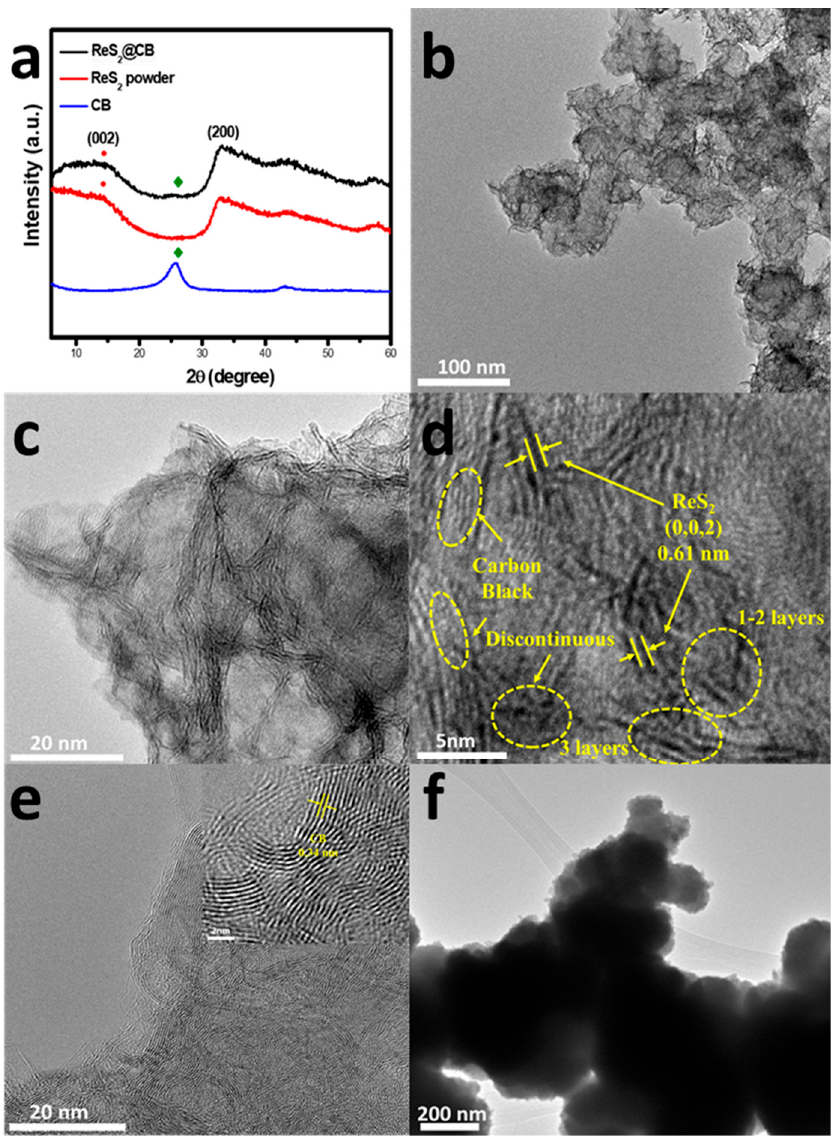
Figure 3. ( a ) XRD pattern of the ReS 2 @CB, ReS 2 powder, and CB; ( b , c ) TEM images of the microstructures of the ReS 2 @CB; ( d , e ) HR-TEM images of the ReS 2 @CB and pure CB; and ( f ) TEM image of the ReS 2 powder.